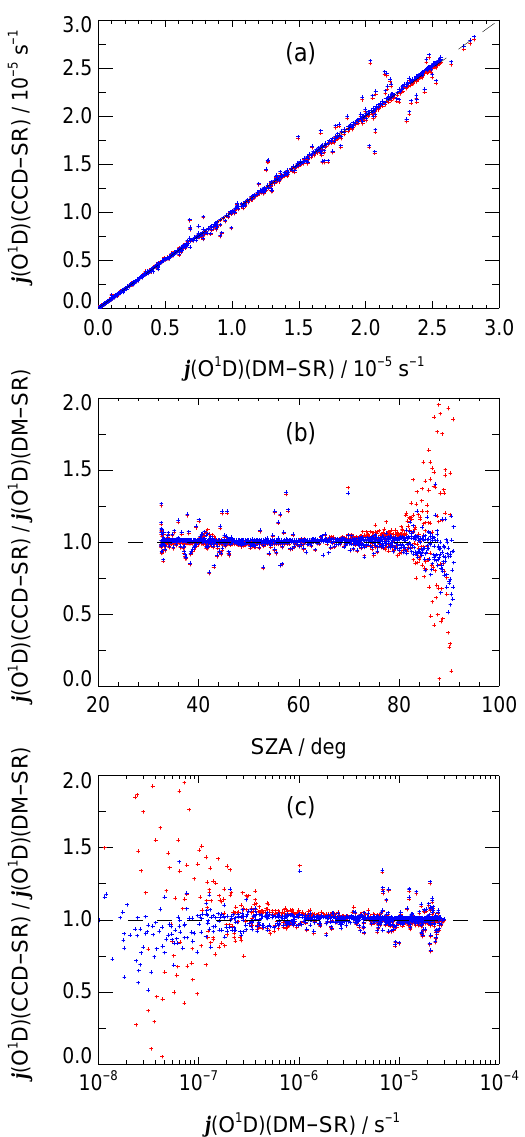
Figure 18. Comparison of j (O 1 D) photolysis frequencies obtained on the ground with a double-monochromator-based reference in- strument (DM-SR) and instrument 62001. Measurements were made during the period 30 July–1 August 2013 at Jülich (Germany). Panel (a) : correlation plot. Panel (b) : ratios as a function of so- lar zenith angles. Panel (c) : ratios as a function of reference values (DM-SR). Dashed lines indicate 1 : 1 relationships. Scatter visible in the correlation plot (upper panel) is caused by clouds, i.e., by synchronization issues. Additional scatter in the ratios towards large SZA (middle panels) and low j (O 1 D) (lower panels) is caused by different detection limits. Blue and red data points were obtained when spectral actinic flux densities below cutoff wavelengths were set to zero and not set to zero,